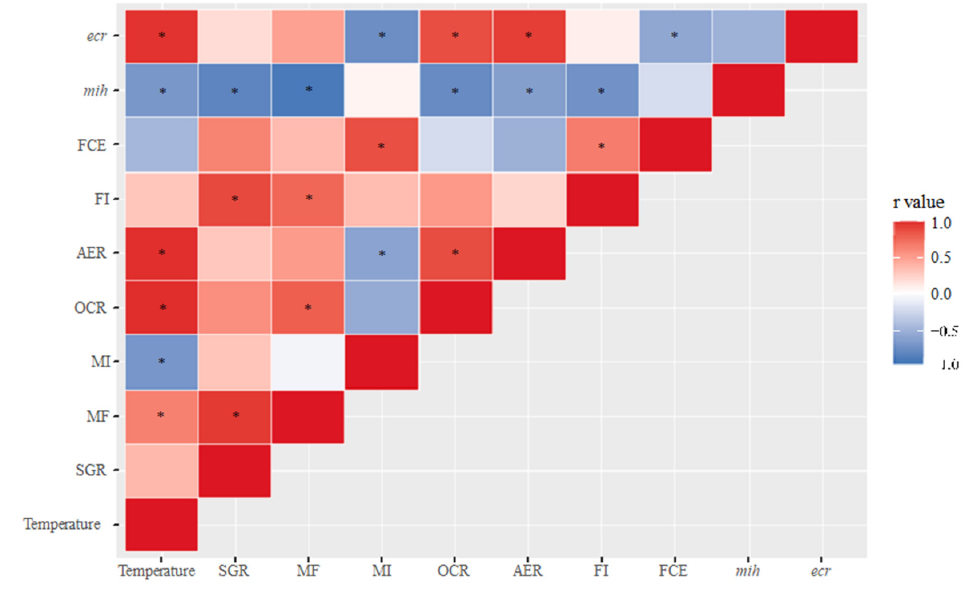
Figure 9. Correlation analyses among temperature SGR, MF, MI, OCR, AER, FI, FCE, and relative expression of mih and ecr gene ( n = 3, 2 individuals per replicate for AER, OCR, ecr , and mih ; n = 3 replicate, and 31, 42, 42, and 42 individuals per treatment of SGR, MF, FI, and FCE). “*” indicates p < 0.05.